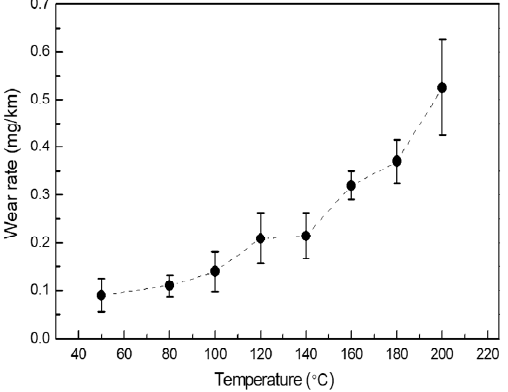
Figure 4. The measured wear rate of GFRPTFE after 15 km sliding at different temperatures.